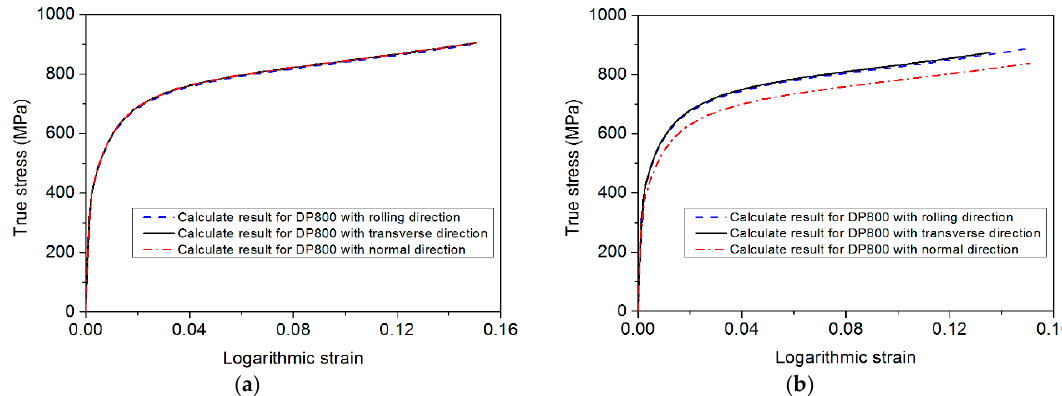
Figure 7. True stress vs. logarithmic strain curves with different stretching directions. ( a ) Real texture results. ( b ) With 30% rotated cube (Rt ‐ C) texture results added.